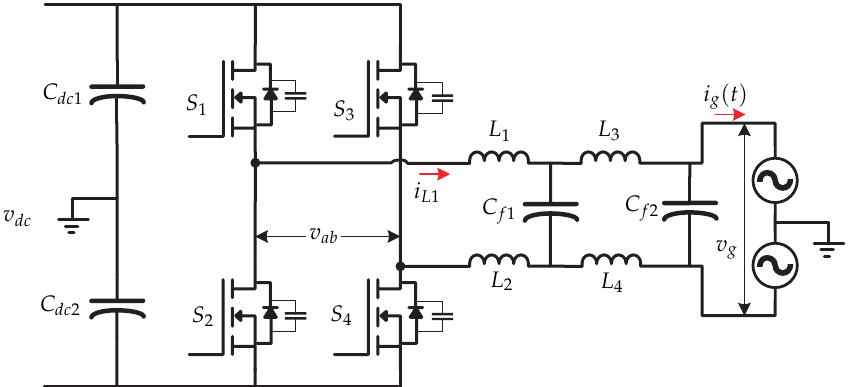
Figure 2. Microinverter’s topology proposed in [12].